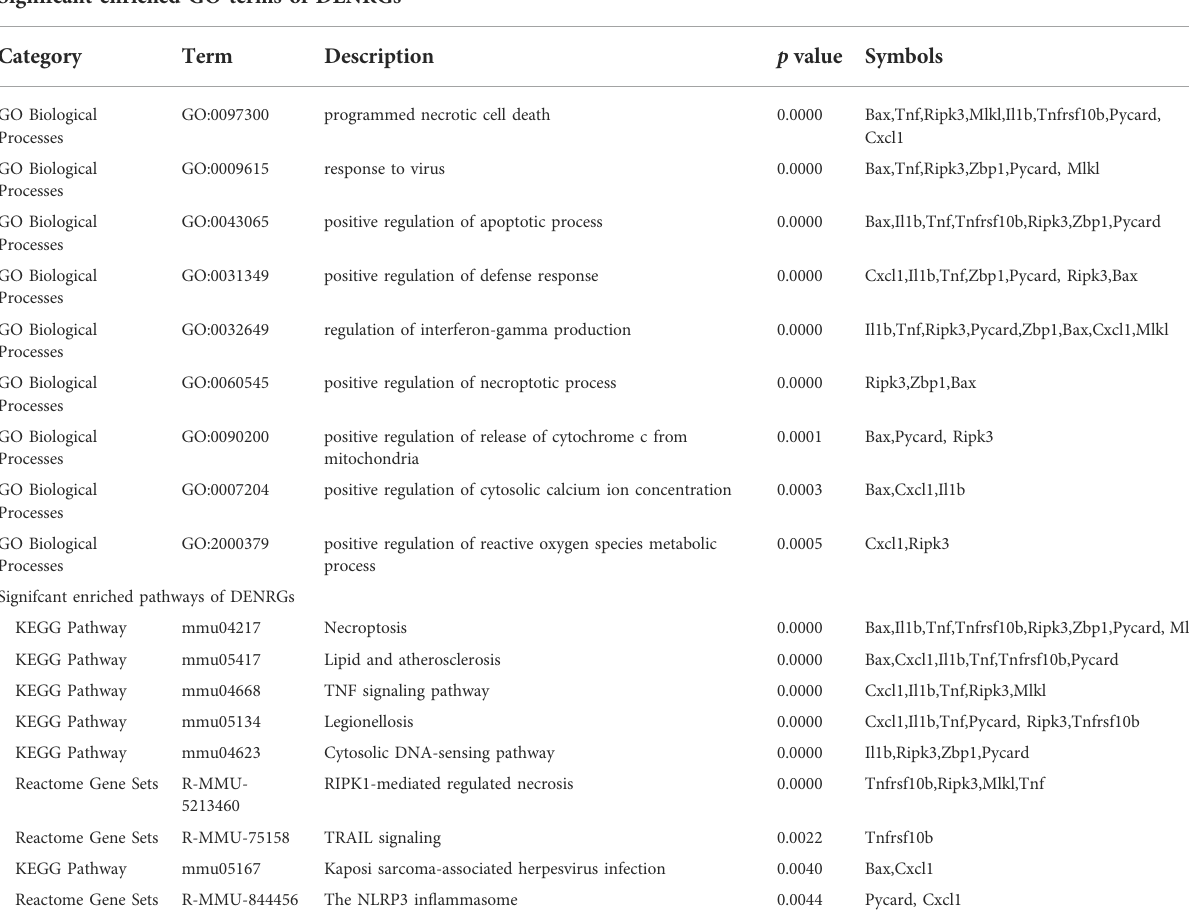
TABLE 3 Functional enrichment analysis of differentially expressed necroptosis-related genes